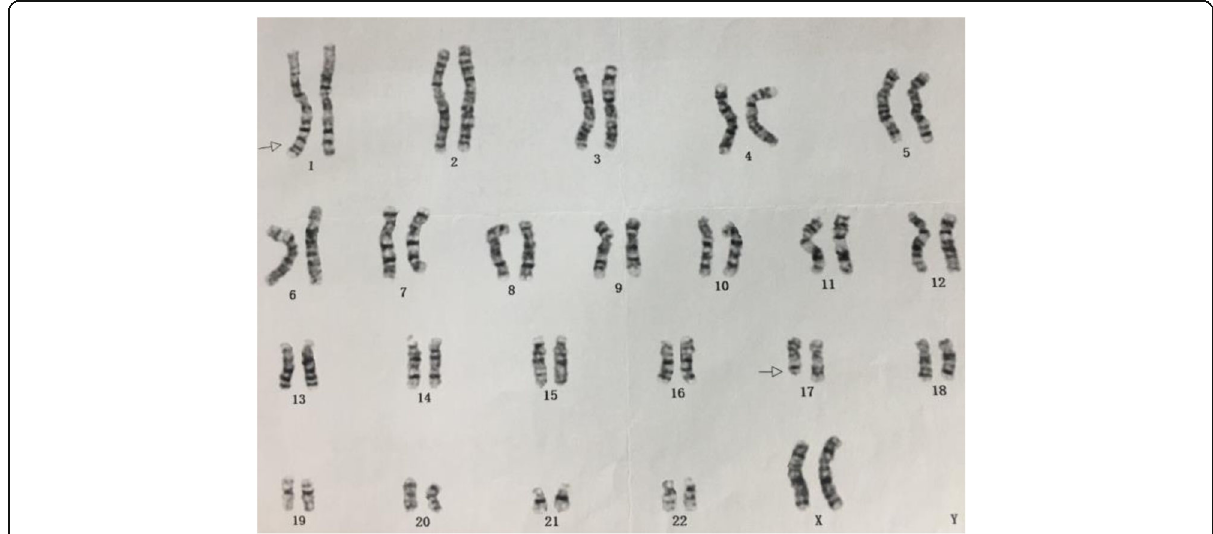
Fig. 1 Metaphase spread in G band Trypsin Giemsa (GTG)-banding obtained from the mother ’ s blood lymphocytes showing 46, XX, t (1;17)(q42;q21). Arrows show abnormal